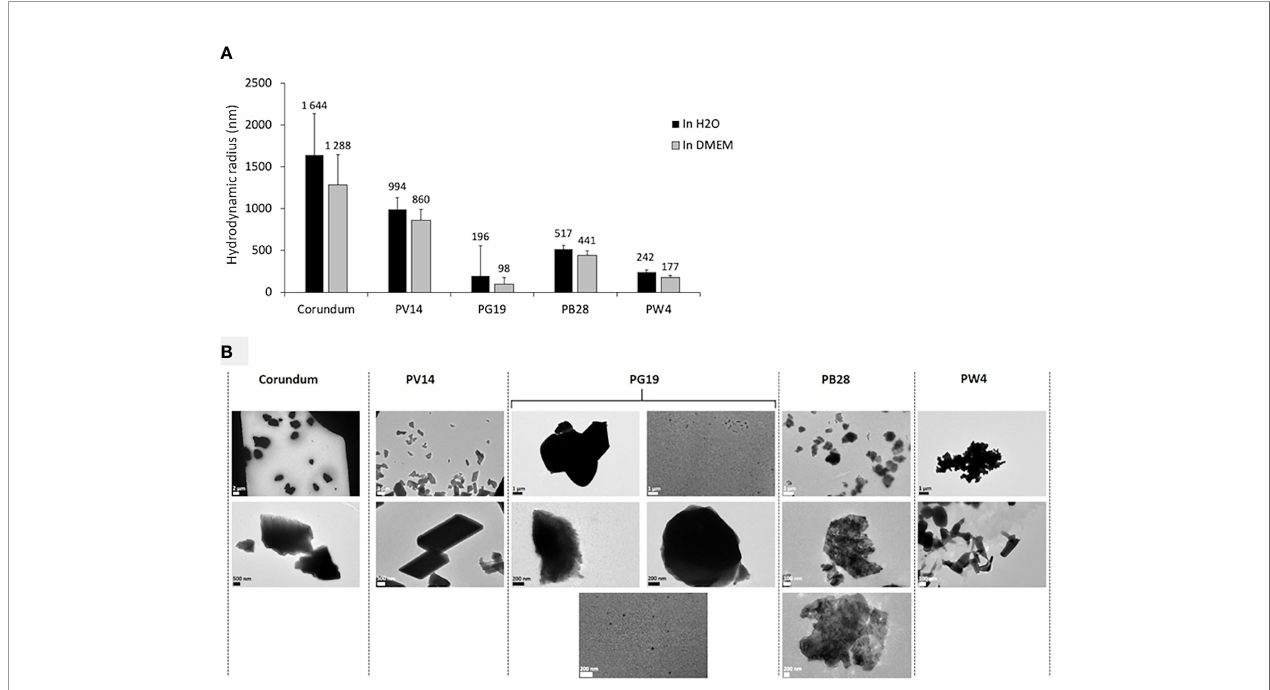
FIGURE 2 | Characterization of pigments PV14, PG19, PB28, PW4 and their corundum control. Panel (A) Hydrodynamic diameter measurement by DLS in H 2 O (in black) and DMEM culture medium (in grey). Panel (B) visualization of pigments by TEM microscopy in H 2